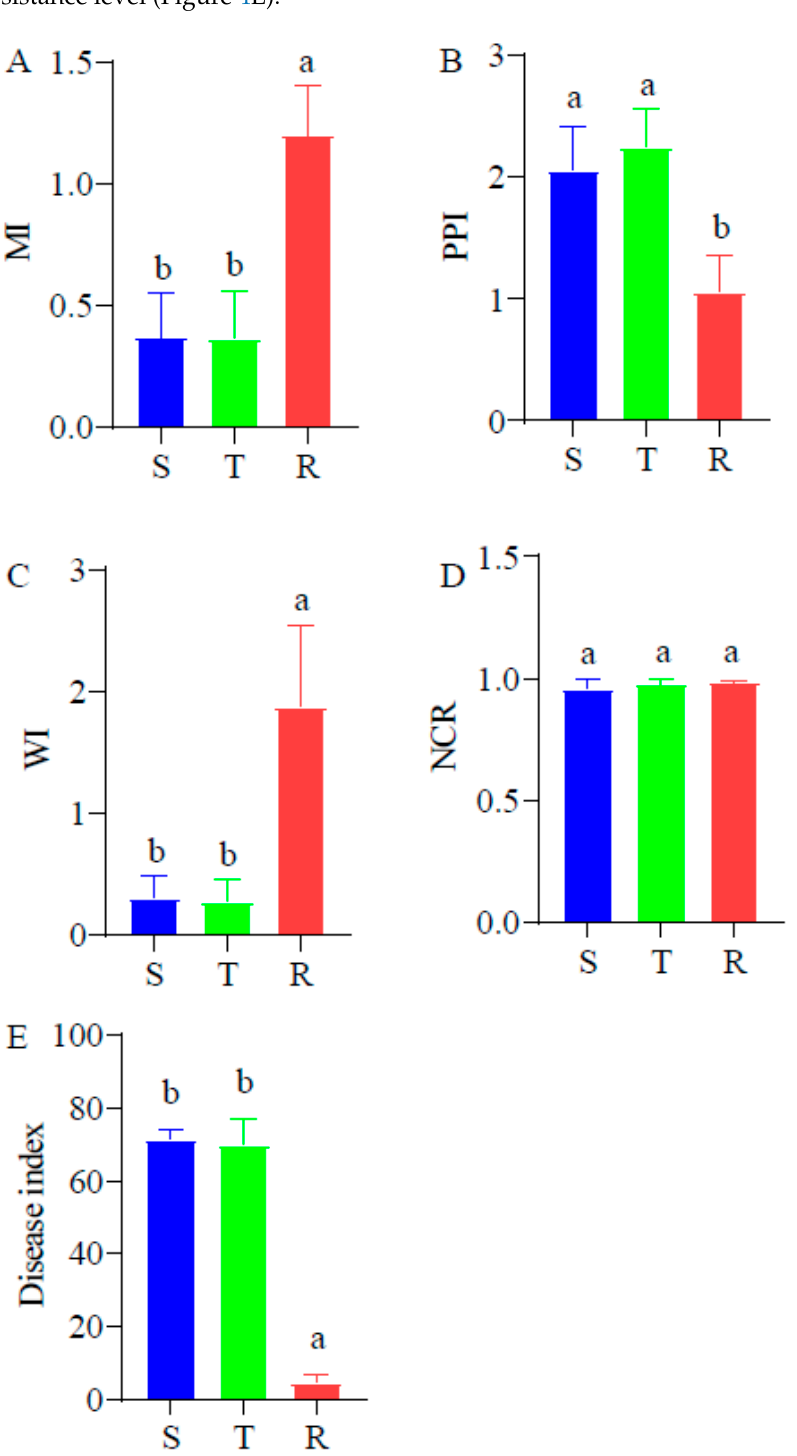
Figure 4. Difference in ecological indices of three soil nematode communities. ( A ), MI. ( B ), PPI. ( C ), WI. ( D ), NCR. ( E ), Disease index. Different letters between the columns show the significant difference among the three soil nematode communities. S: susceptible cultivar. T: tolerant cultivar; R: resistant cultivar.